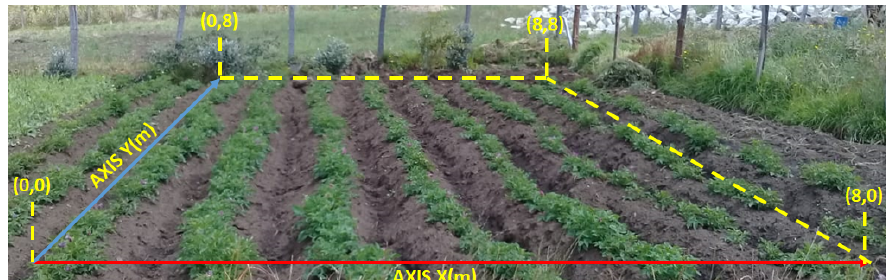
Figure 1. Proposed architecture for soil moisture estimation and optimal node positioning.